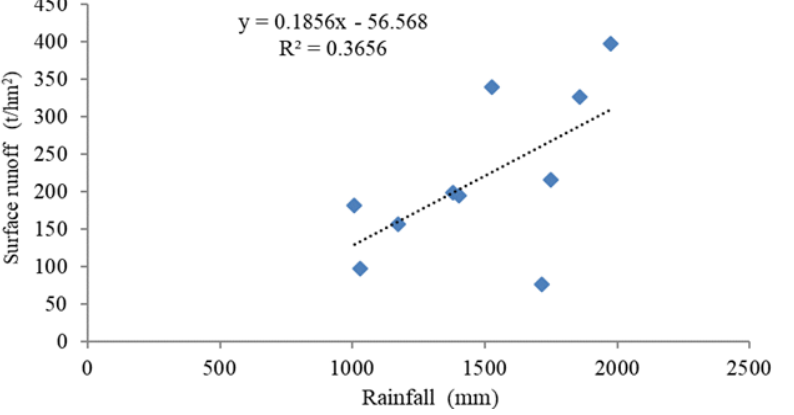
Figure 11. Relationship between rainfall and surface runoff.